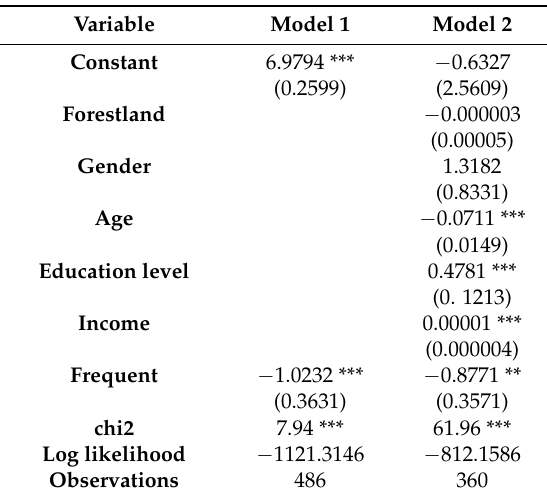
Table 2. Random effects Tobit estimates 1 .